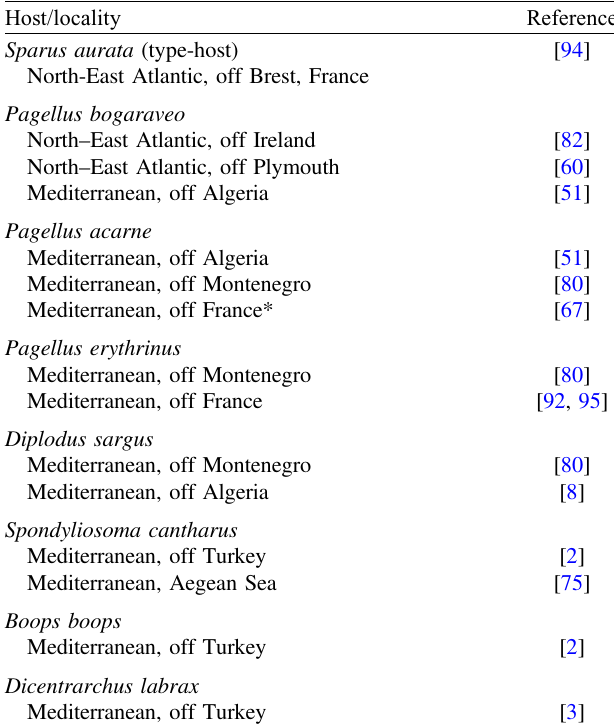
Table 4. Hosts and localities of Choricotyle chrysophryi reported in the